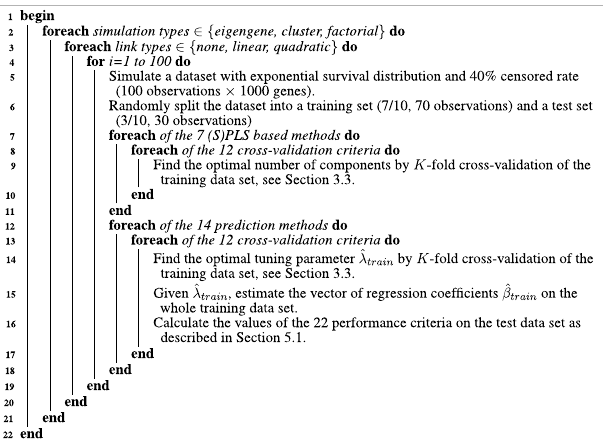
Algorithm 2 | Summary of the procedure for evaluating the accuracy of the cross validation methods and revisit the performance of the component based